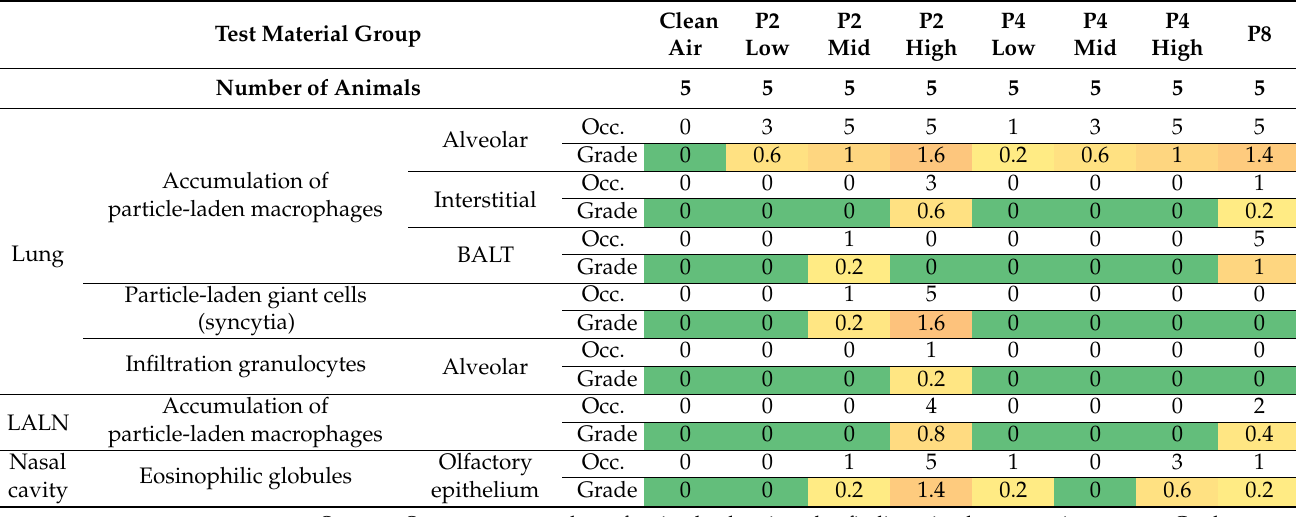
Table 4. GRNP-related histopathological findings at day 29 post-exposure.